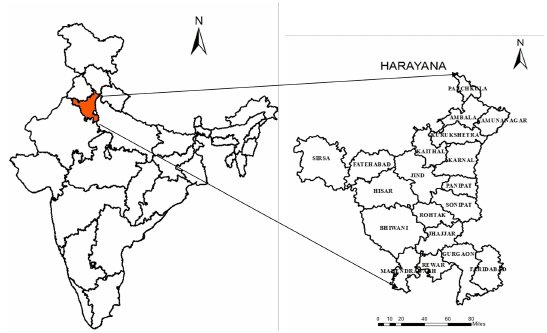
Figure 3.1 Area of the present